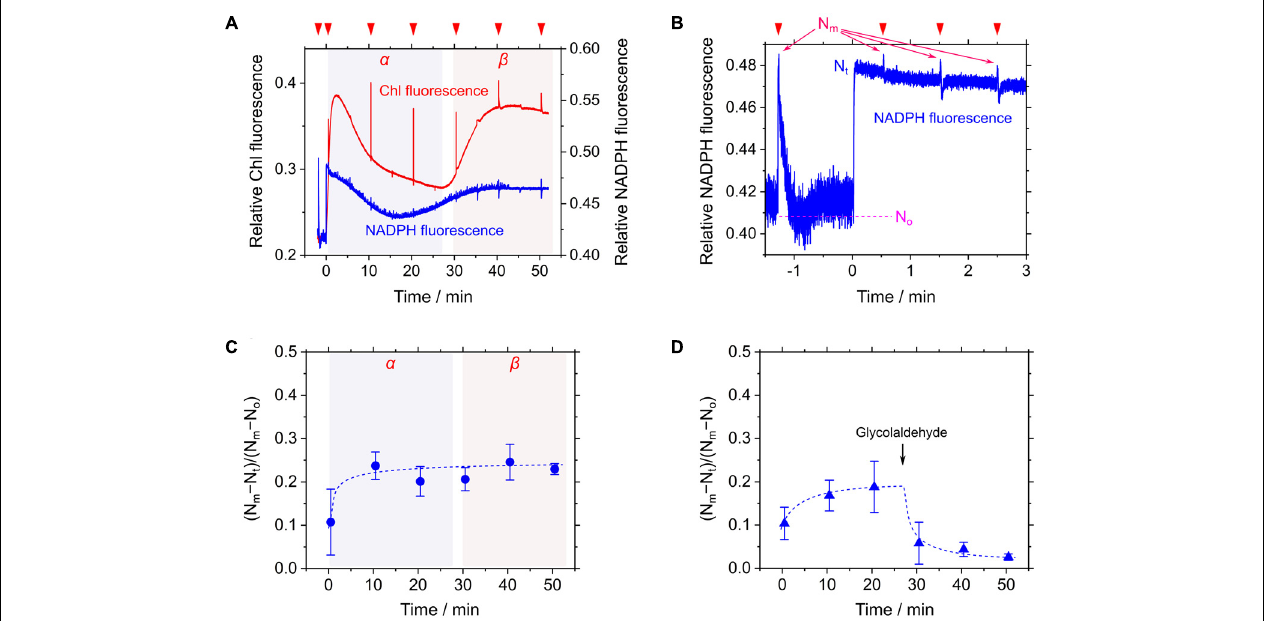
FIGURE 3 | Responses of relative chlorophyll (Chl) and NADPH fluorescence to CO 2 limitation in Synechococcus elongatus PCC 7942. (A) Time courses of relative Chl (red line) and NADPH (blue line) fluorescence during the transition from phase α to β of photosynthesis. Inverted red triangles show the application of the saturated short-pulse light. (B) The kinetics of NADPH fluorescence for the calculation of the oxidation fraction of NADP + pool during the measurement. The use of the term N m , N o , and N t are according to Schreiber and Klughammer (2009) (see “Materials and Methods”). The line graphs (A,B) show the representative results of three experiments (technical replicates). (C,D) Time courses of the oxidation fraction of NADP+ pool, (N m − N t )/(N m − N o ), in the transition from phase α to β of photosynthesis (C) and in response to added 25 mM glycolaldehyde (D) . Data are mean ± the standard deviation of three experiments (technical replicates).